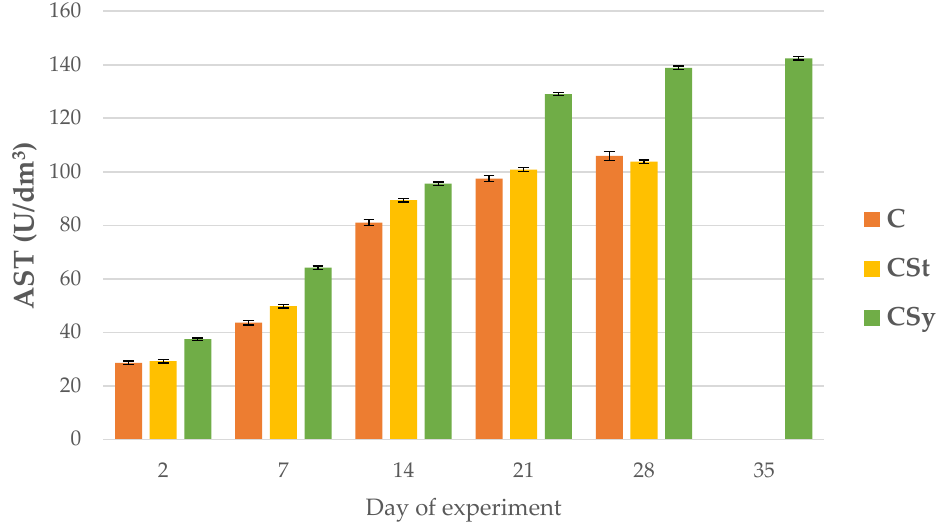
Figure 9. AST activities in the 2, 7, 14, 21, 28, 35-day-old honey bees’ hemolymph after two methods of supplementation with hemp extract: C-control (pure sugar syrup), CSy-hemp extract in syrup, CSt-hemp extract on strips. Two-Way ANOVA: supplementation method: F (2, 156) = 13.130, p = 0.00001, se ± 4.891108 – 4.420075; days of supplementation: F (4, 143) = 58610, p = 0.0000; se ± 0.149875 – 0.259592; supplementation method × days of supplementation F (8, 143) = 705.49, p = 0.0000, se ± 0.2595952 – 0.273634.